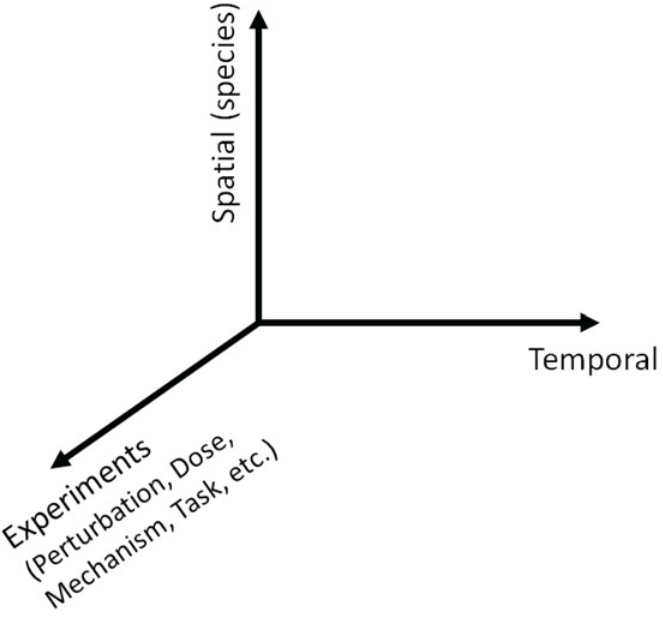
Fig 1. Multi-dimensional spatio-temporal data. We consider various experiments with different perturbations, doses, mechanism, tasks,